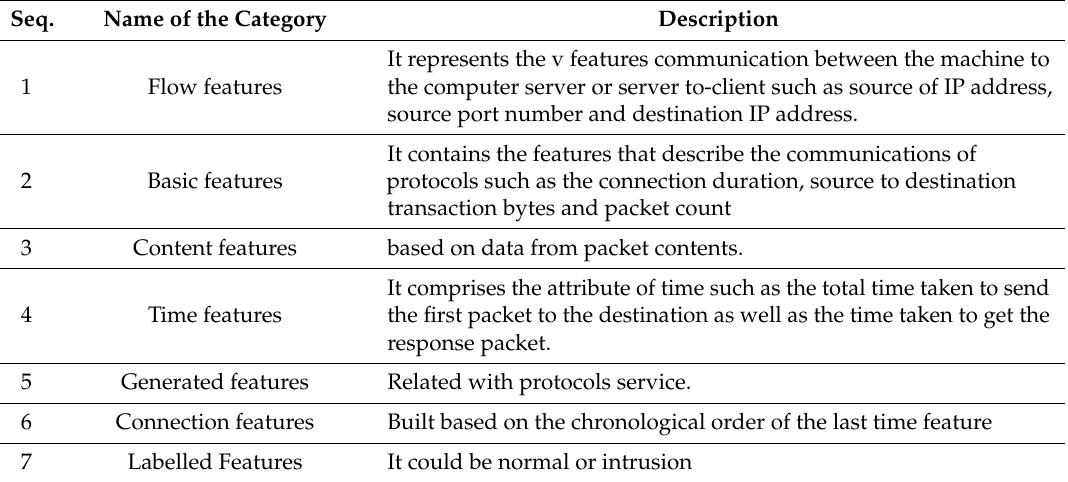
Table 2. ADFA-LD (ADFA Linux) dataset features.